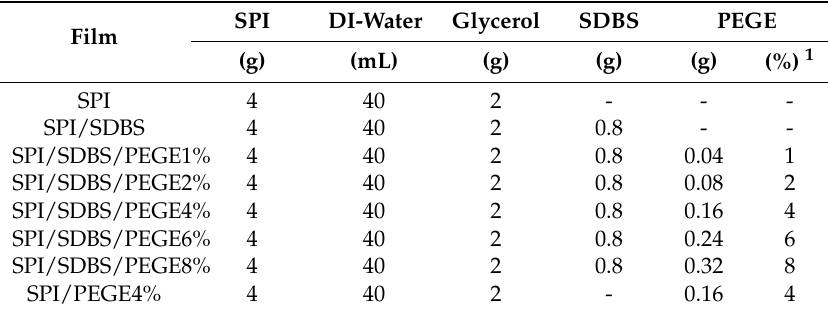
Table 1. Feedstocks for preparing SPI-based